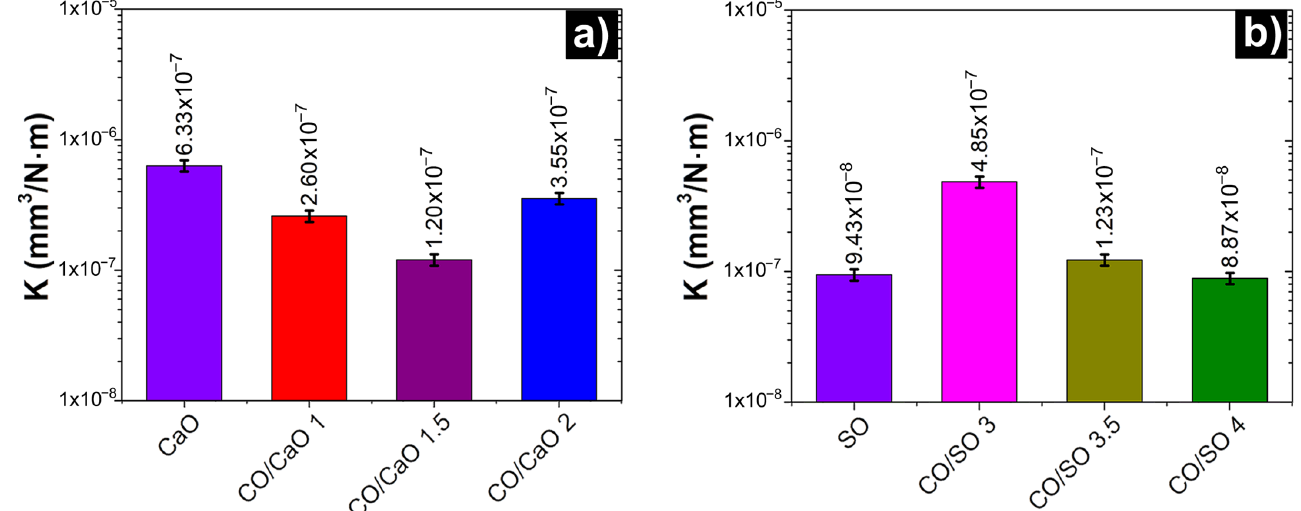
Figure 8. Influence of CO/CaO ( a ) and CO/SO ( b ) binary oil mixtures as green lubricants in the wear rate (K) of the AISI 8620 steel.